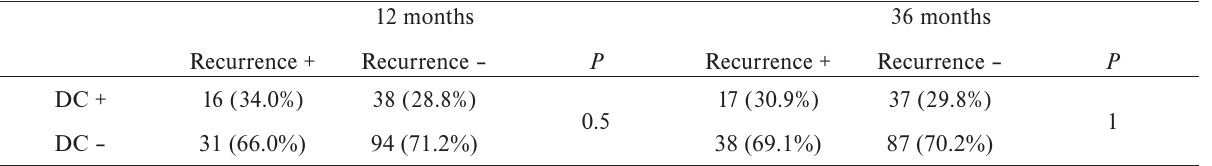
Table 2. The difference in DC absence or presence in patients with and without AF recurrence (at 12 and 36 months). 12 months